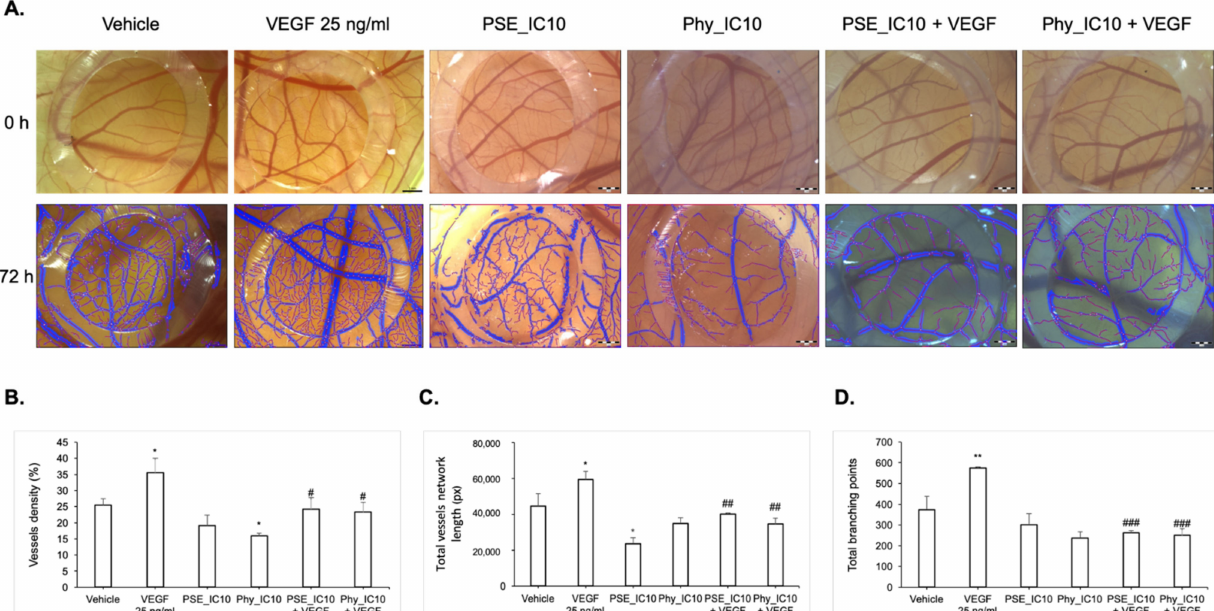
Figure 10. Effects of PSE and Phy on blood vessel formation in the ex ovo CAM (chorioallantoic membrane) assay. ( A ) Representative digital images of the most effective 72 h treatment with PSE and Phy in the presence or absence of VEGF (25 ng/mL). Quantitative analysis of angiogenesis by measuring vessels’ density ( B ), total vessels’ network length ( C ) and total branching points ( D ) based on the WimCAM data. Error bars represent mean ± SD (* p < 0.05, ** p < 0.01 versus vehicle; # p < 0.05, ## p < 0.01, ### p < 0.001 versus VEGF